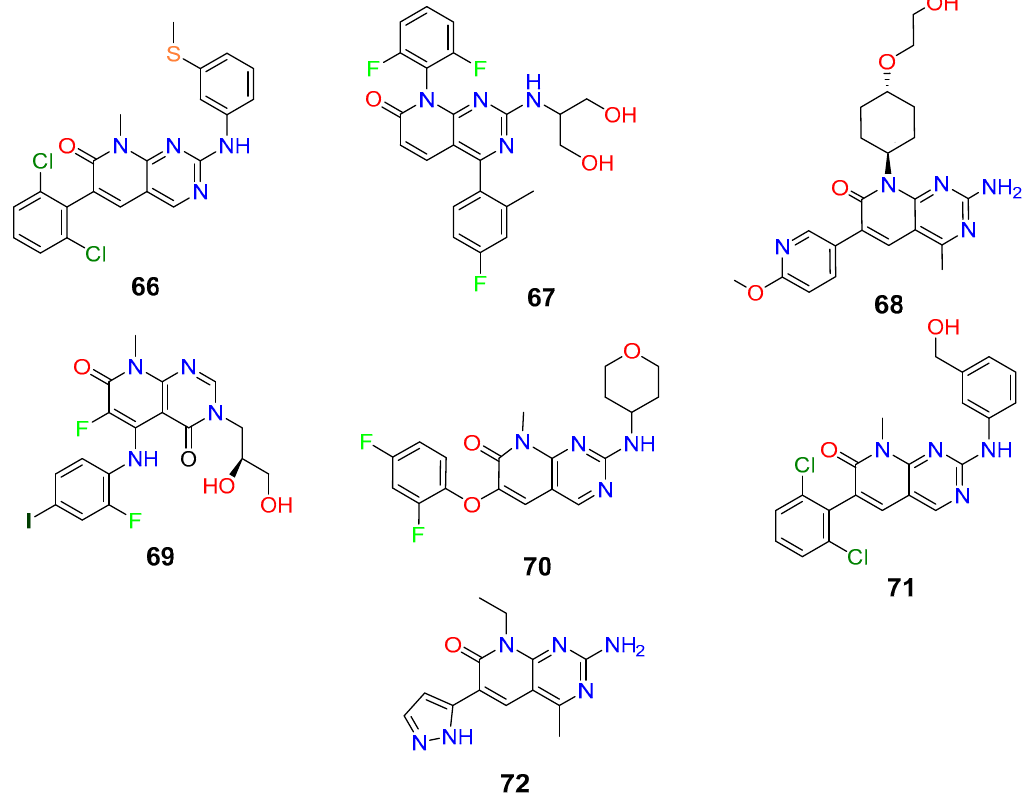
Figure 22. Structures of pyrido[2,3- d ]pyrimidin-7(8 H )-ones ( 10 ) included in Drugbank which are in different phases of development.